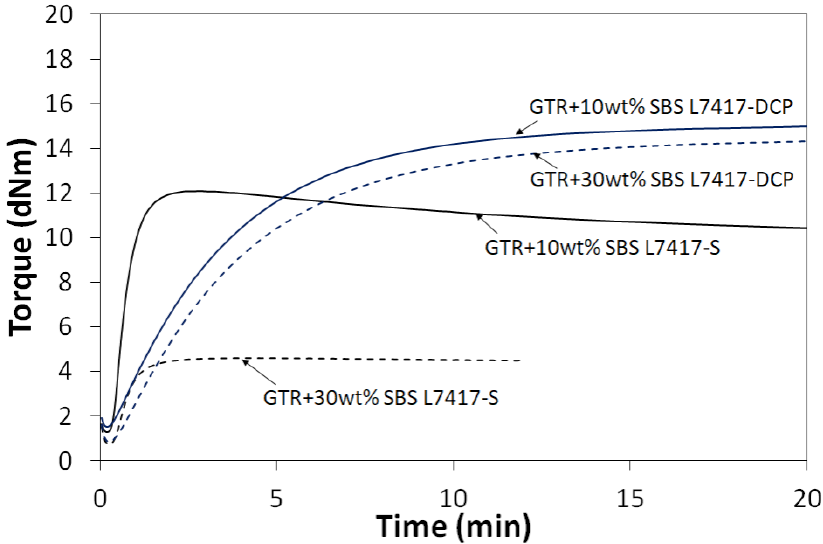
Figure 6. Curing curves of GTR modified by SBS and cross-linking agents. Table 2. Mooney viscosity and curing parameters of GTR modified by SBS and cross-linking agents. Sample Coding Sample